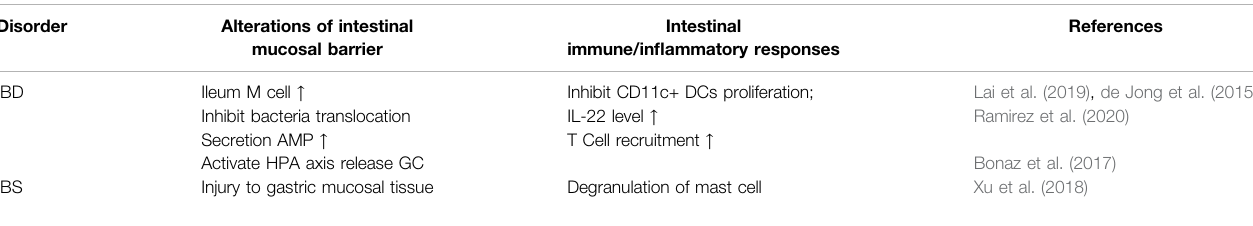
TABLE 3 | Summary of Afferent nerve-intestinal immunity manifestations in different diseases.